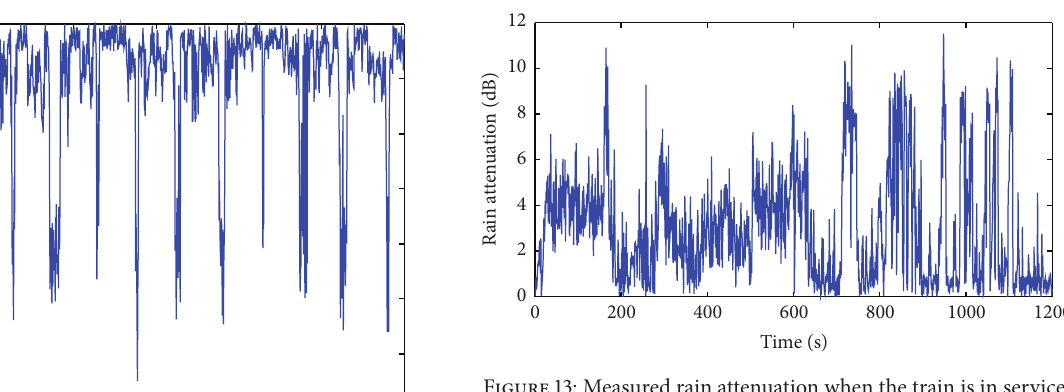
Figure 13: Measured rain attenuation when the train is in service.